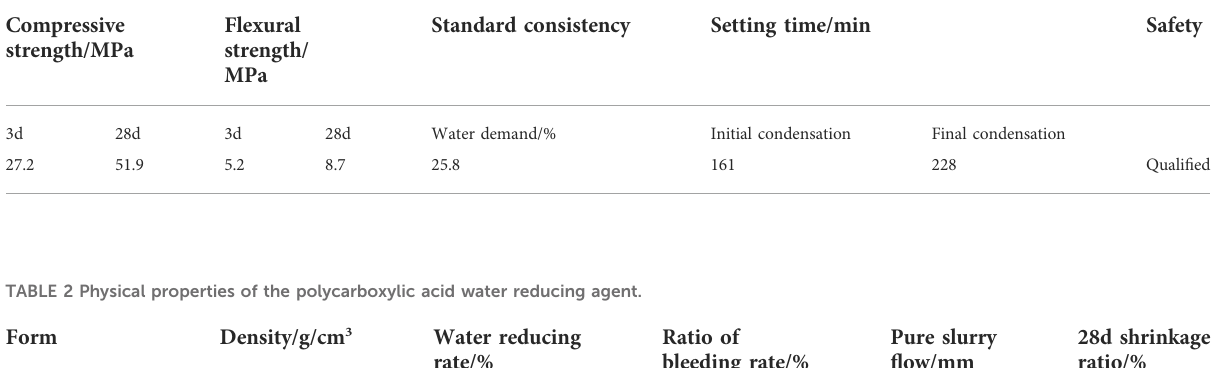
TABLE 1 Technical properties of the cement.